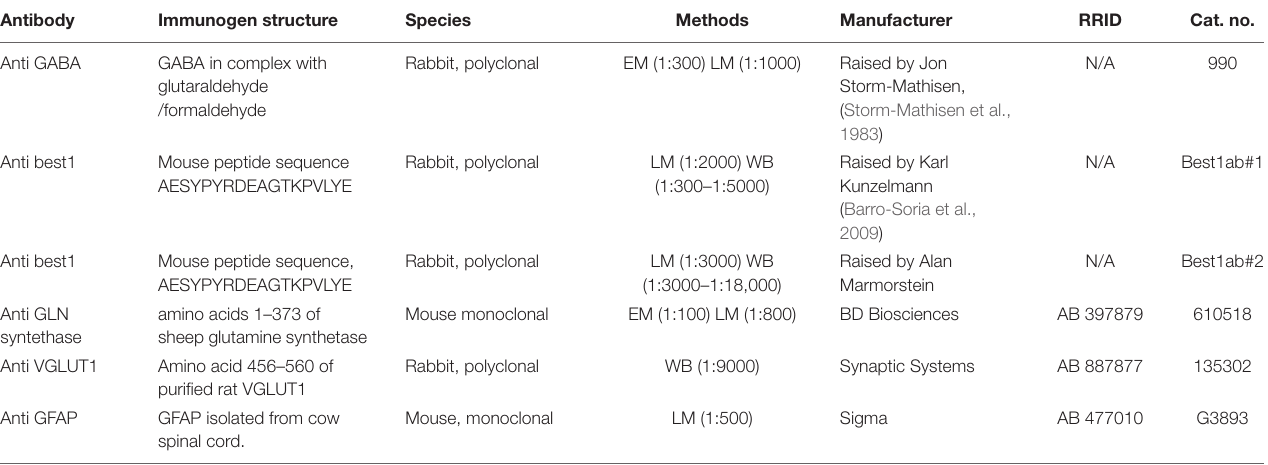
TABLE 1 | Information about the primary